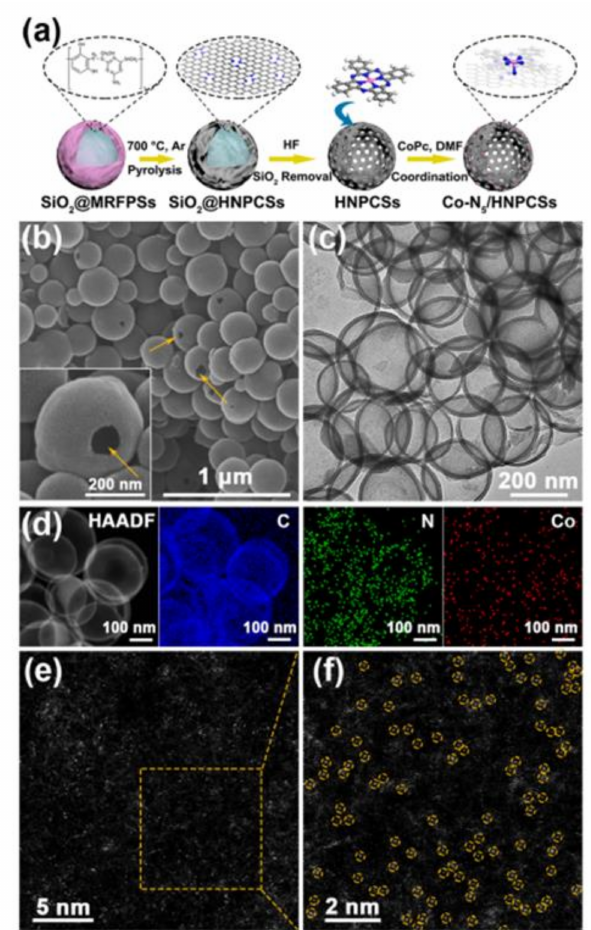
Figure 8. Co-N 5 as effective active sites for the CO 2 RR to CO. ( a ) Scheme of the Co–N 5 /HNPCSs synthesis; ( b ) SEM, ( c ) TEM, ( d ) HAADF-STEM and EDS images of the Co-N 5 /HNPCSs catalyst (C atoms in blue, N atoms in green and Co atoms in red). ( e , f ) Aberration corrected HAADF-STEM image and a further HAADF-STEM magnified image of the Co-N 5 /HNPCSs catalyst. Reprinted with permission from Ref. [67]. Copyright 2022 American Chemical